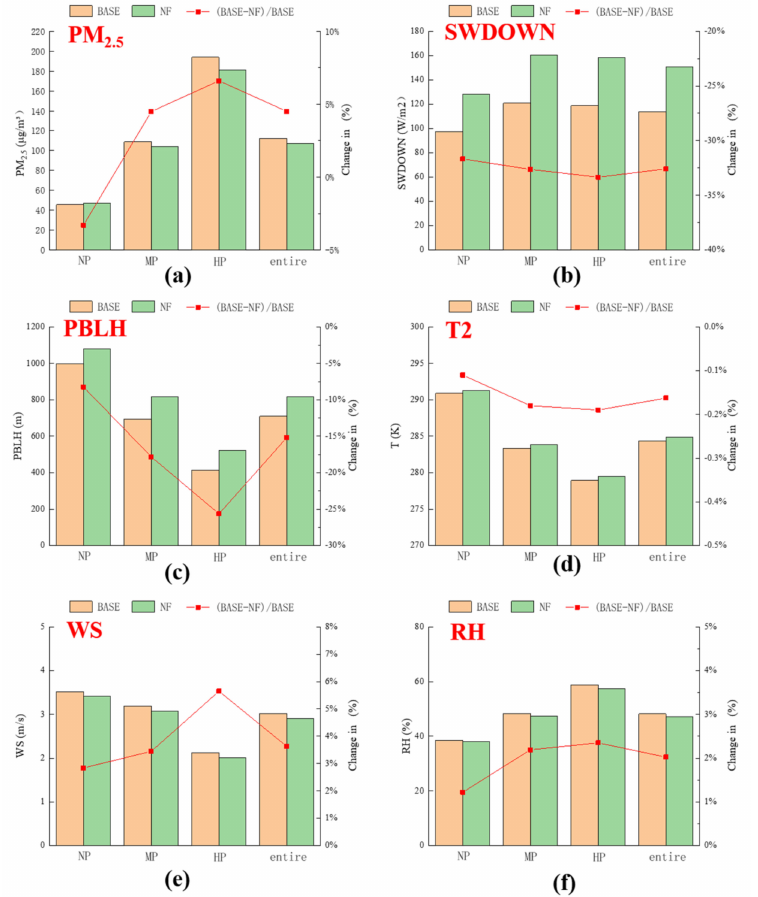
Figure 6. Changes of simulated aerosols feedback effect on PM 2.5 ( a ), SWDOWN ( b ), PBLH ( c ), T2 ( d ), WS ( e ) and RH ( f ) in percentage on non-pollution, mild-moderate pollution and heavy pollution in Handan during the investigation